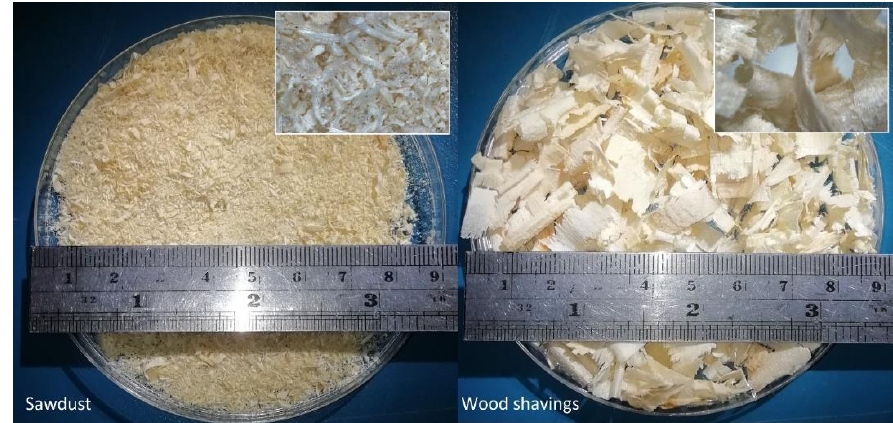
Figure 2. Left: Sawdust additive. Right: Shavings additive.